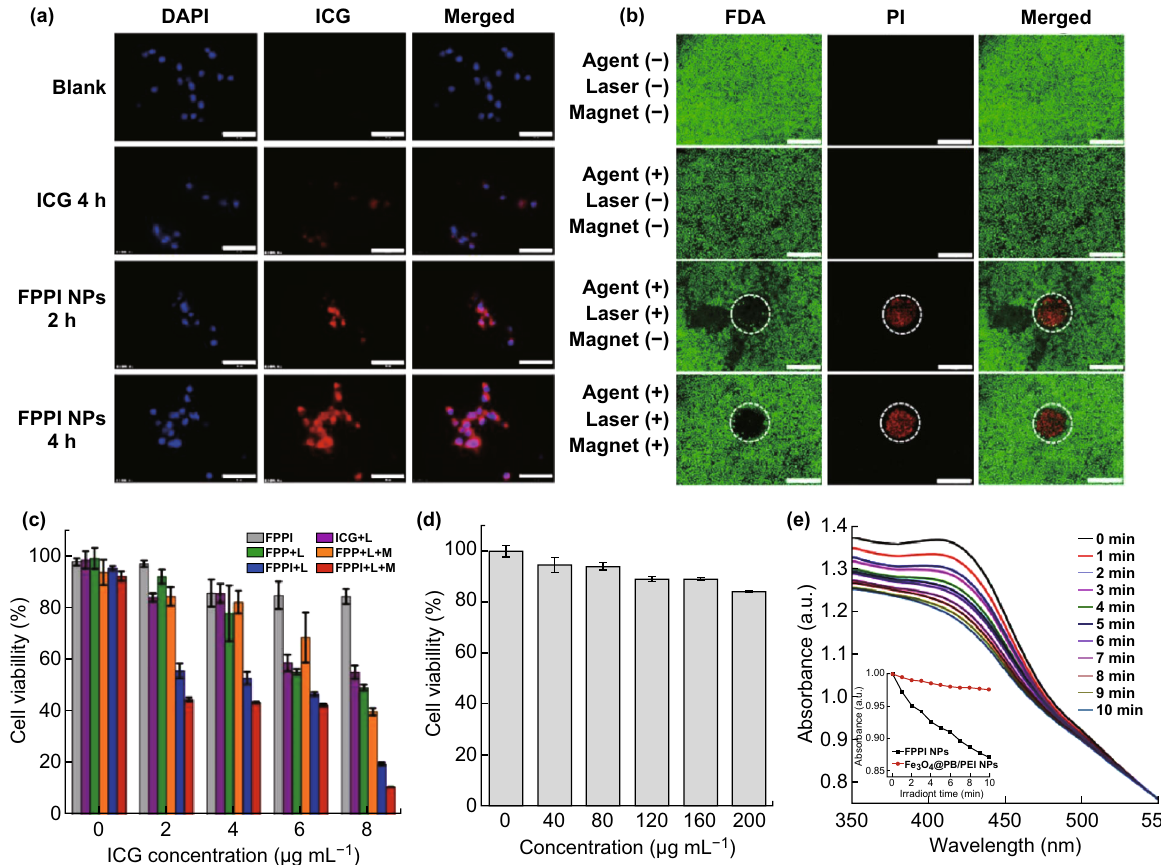
Fig. 4 a Microscopic analysis of HeLa cells treated with free ICG or FPPI NPs (at the same equivalent ICG concentration) for 2 h and 4 h (scale bars: 100 l m; excitation wavelength: 633 nm). Untreated cells served as the blank control. b LIVE/DEAD assays after various treatment combinations, where laser irradiation spots are denoted by dashed circular areas (scale bars: 500 l m). Viable cells and dead cells were stained with green and red fluorescence, respectively. c HeLa cell viability after treatment with free ICG, FPP NPs, or FPPI NPs subjected to laser irradiation (‘‘L’’) or magnetic field (‘‘M’’) where applicable. d Impact of FPPI NPs on HUVEC viability after 24 h under various NP concentrations measured by MTT assays. e Change in UV–Vis absorbance spectra of FPPI NPs containing DPBF under NIR laser irradiation